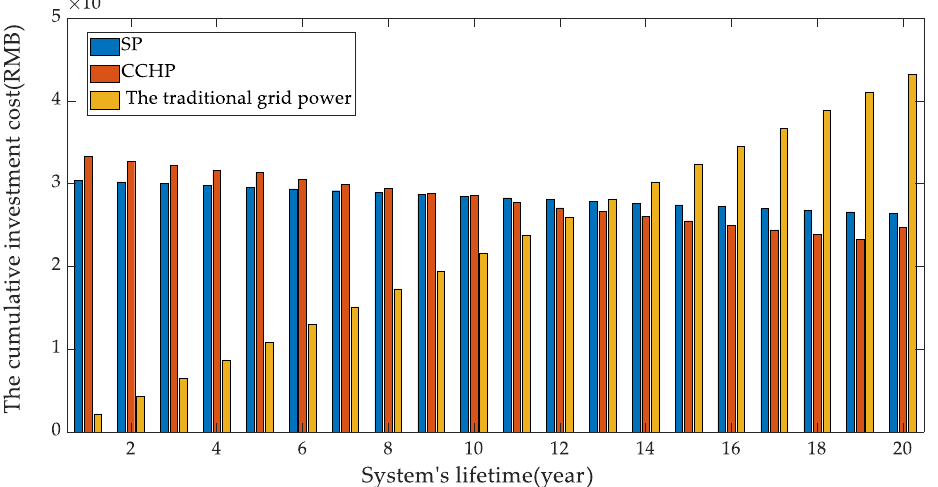
Figure 9. The cumulative investment cost of the proposed CCHP system, the SP and the traditional grid power system.